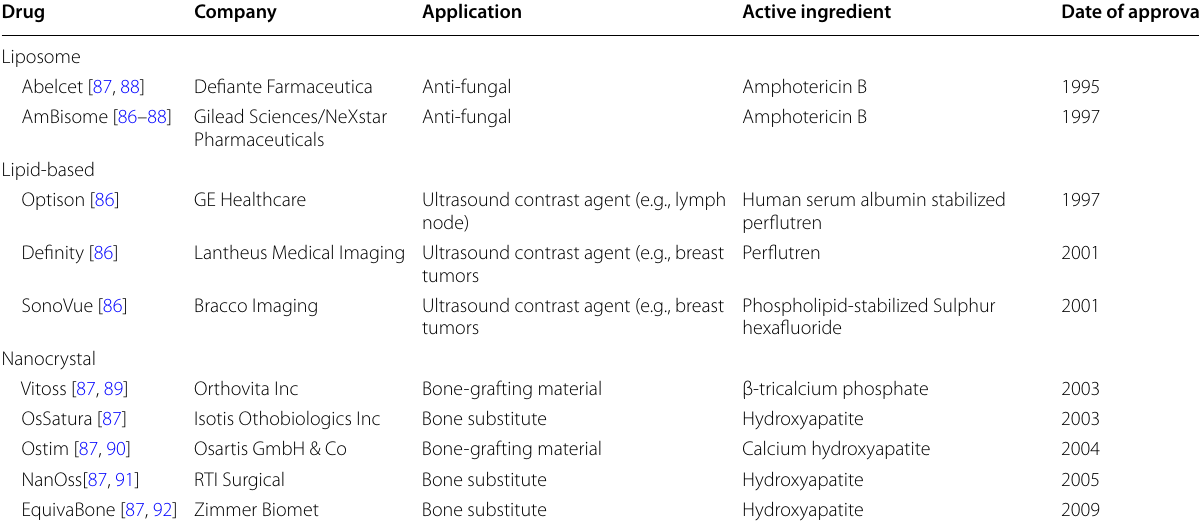
Table 1 Summary table of approved nanomedicine/nanoparticle-based delivery system with potential plastics and reconstructive surgery